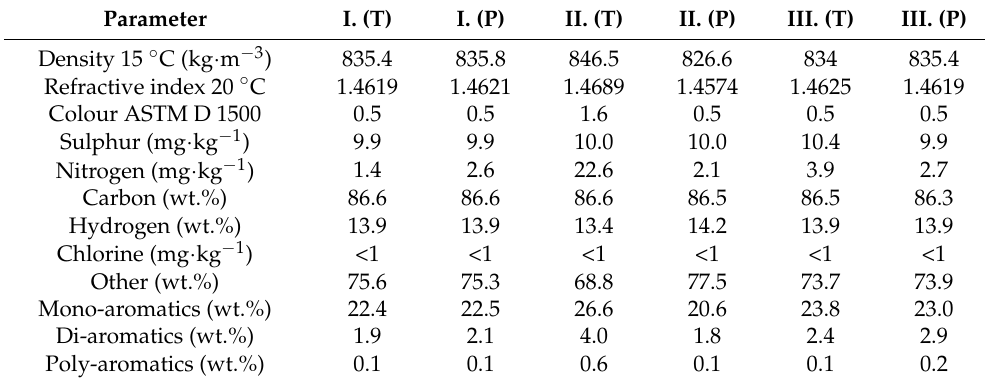
Table 7. Average values of the products obtained under each condition.